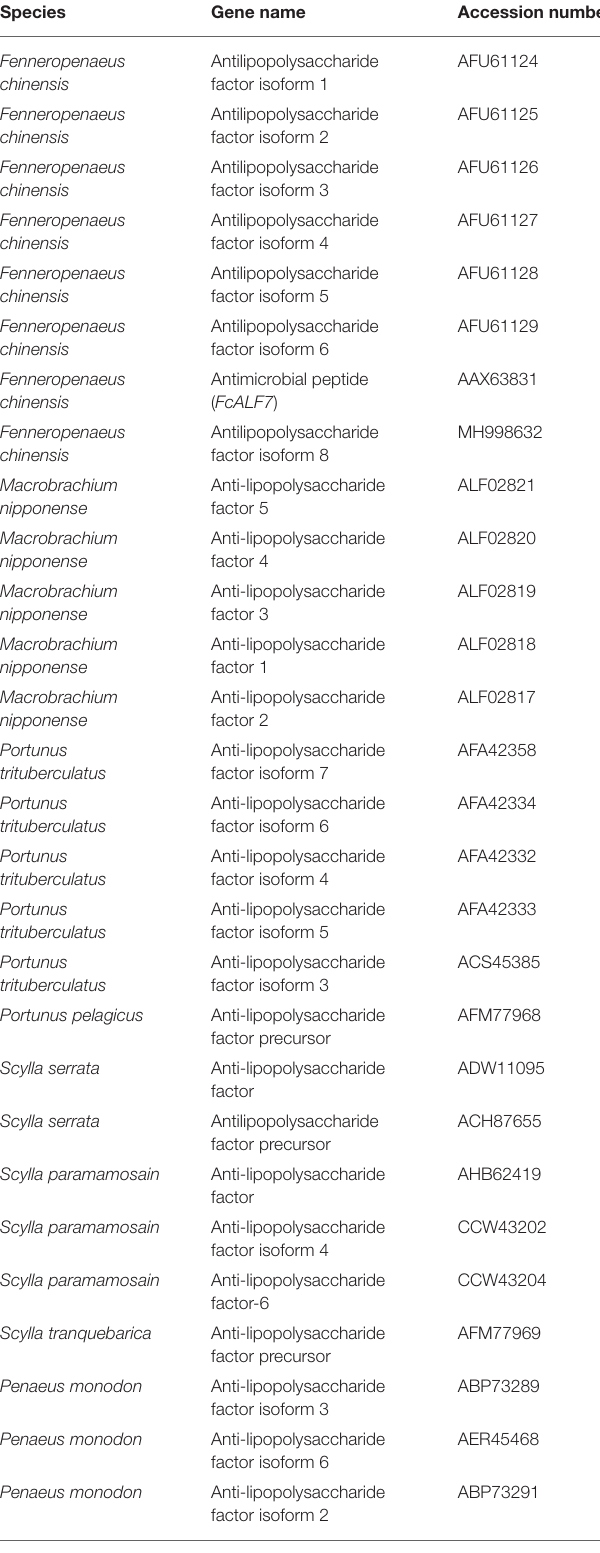
TABLE 2 | The information of ALFs used in the present study.